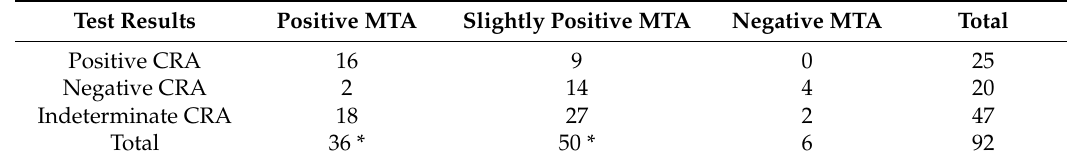
Table 1. Summary of the results of tested